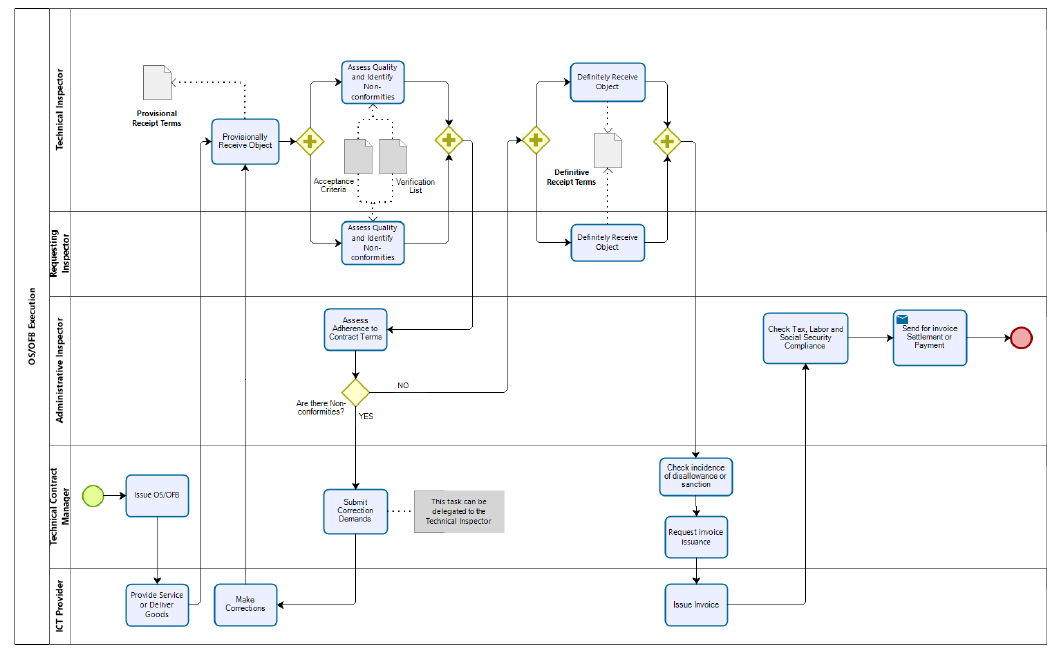
Figure 3. Initial execution of the Service Order (OS)/Order for the Supply of Goods (OFB).